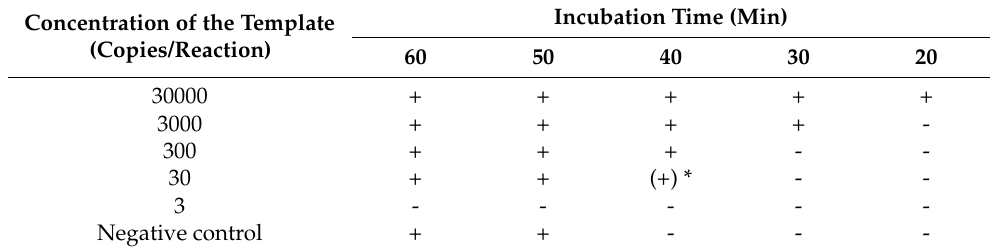
Table 5. Limit of detection for RT ‐ LAMP combined with LFA using control RNA as a template.